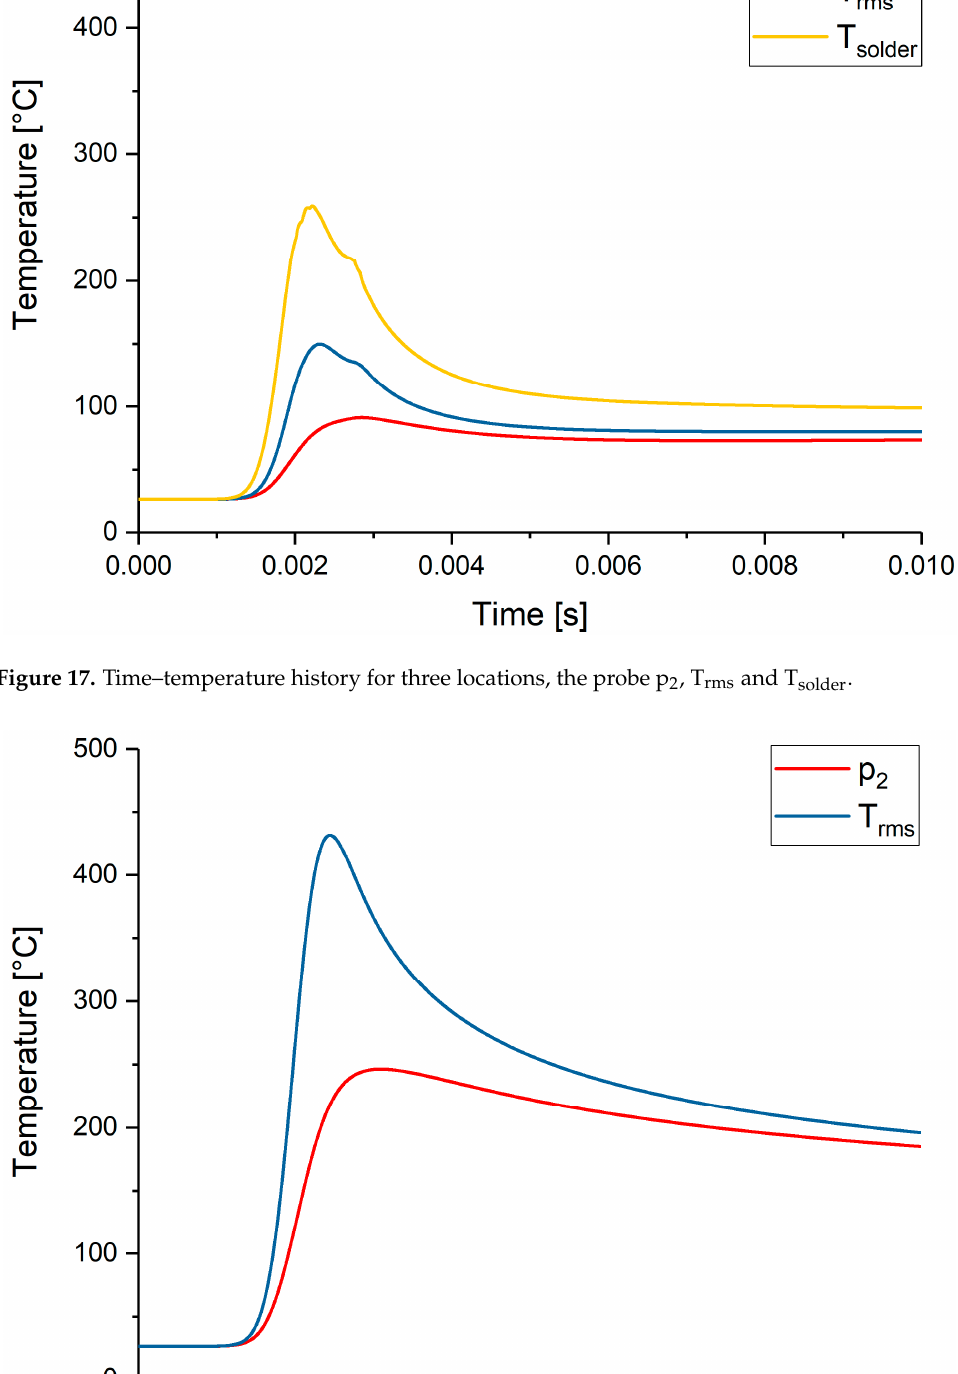
Figure 18. Time–temperature history for p 2 and T rms , without solder and silicon.